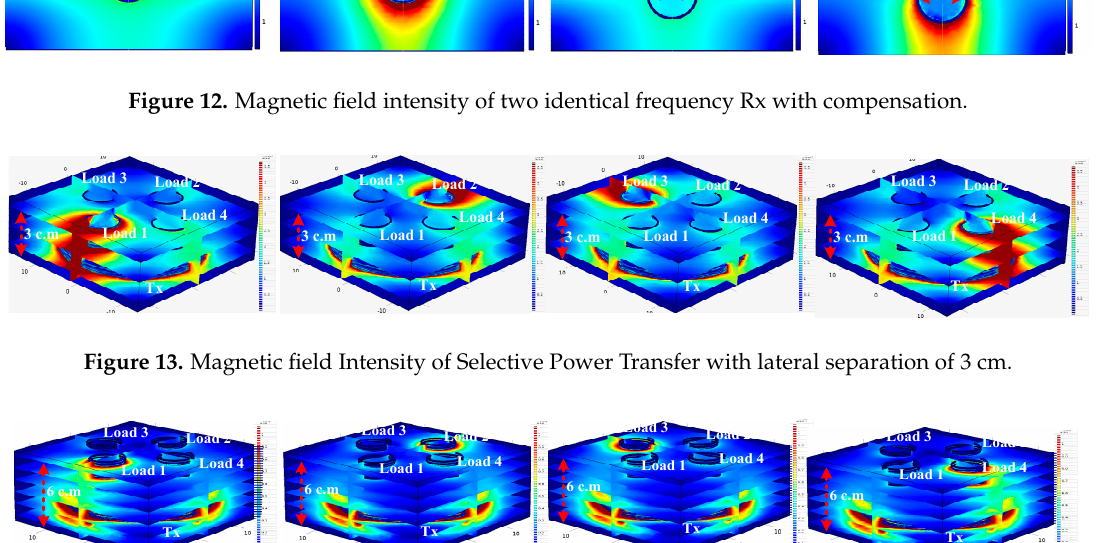
Figure 14. Magnetic field Intensity of Selective Power Transfer with lateral separation of 6 cm.